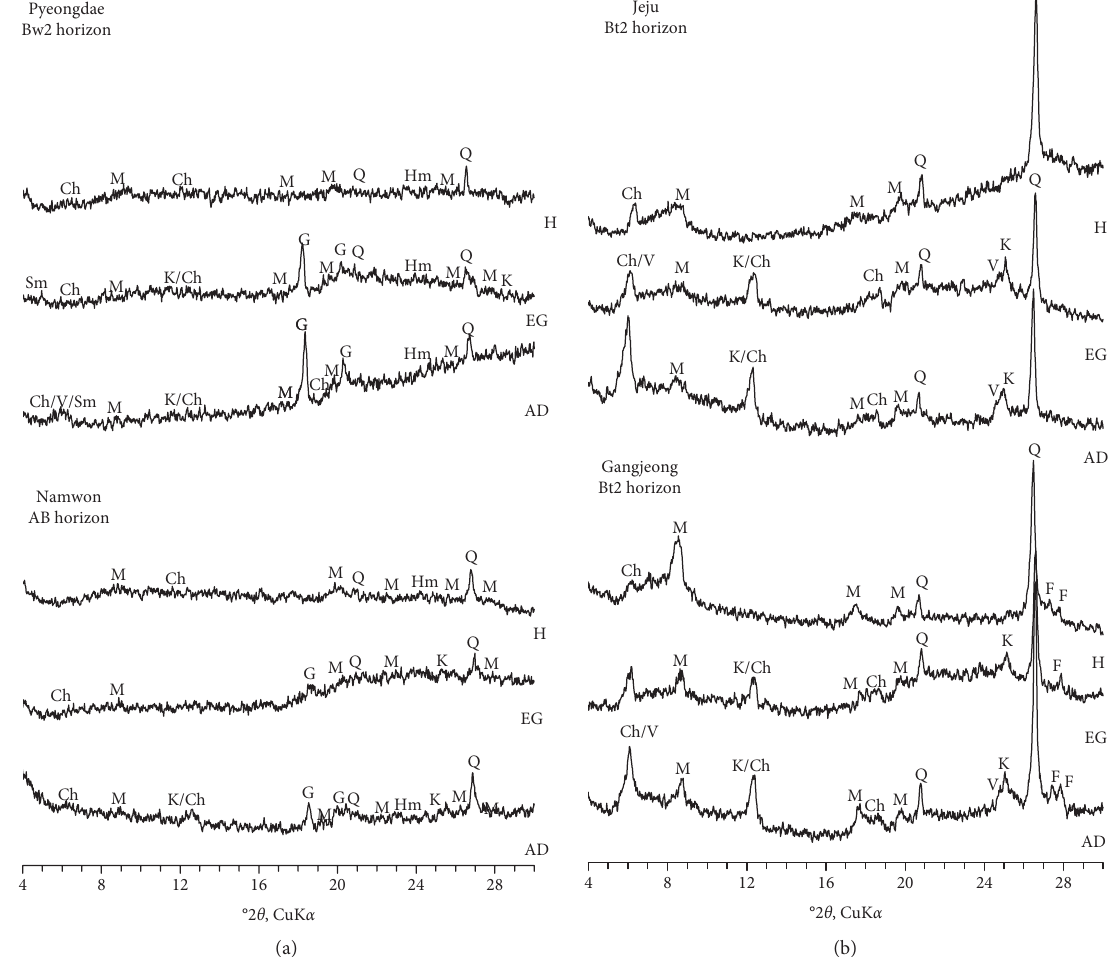
Figure 2: X-ray diffraction patterns of the clay fraction of selected horizons. AD: air-dried; EG: ethylene glycolated; H: heated at 550 ° C; Q: quartz; Ch: chlorite; M: mica/illite; Sm: smectite; K: kaolinite; V: vermiculite; G: gibbsite; F: feldspar; Hm: hematite.